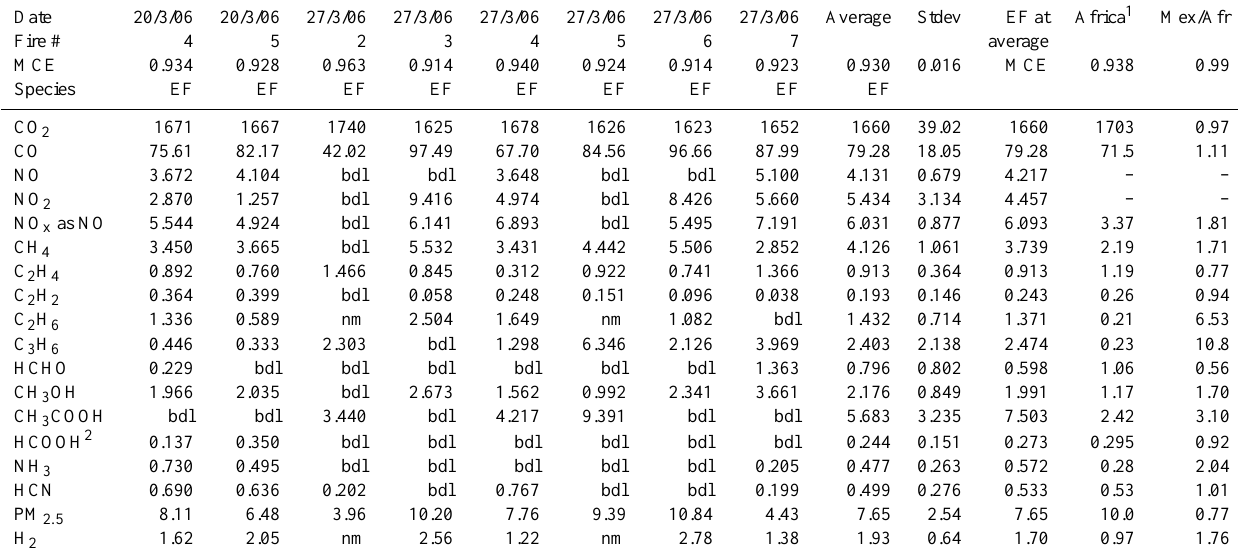
Table 5. Emission factors (EF, gkg − 1 ) and modified combustion efficiency (MCE) measured for early dry season savanna fires in Mexico compared to late dry season data from